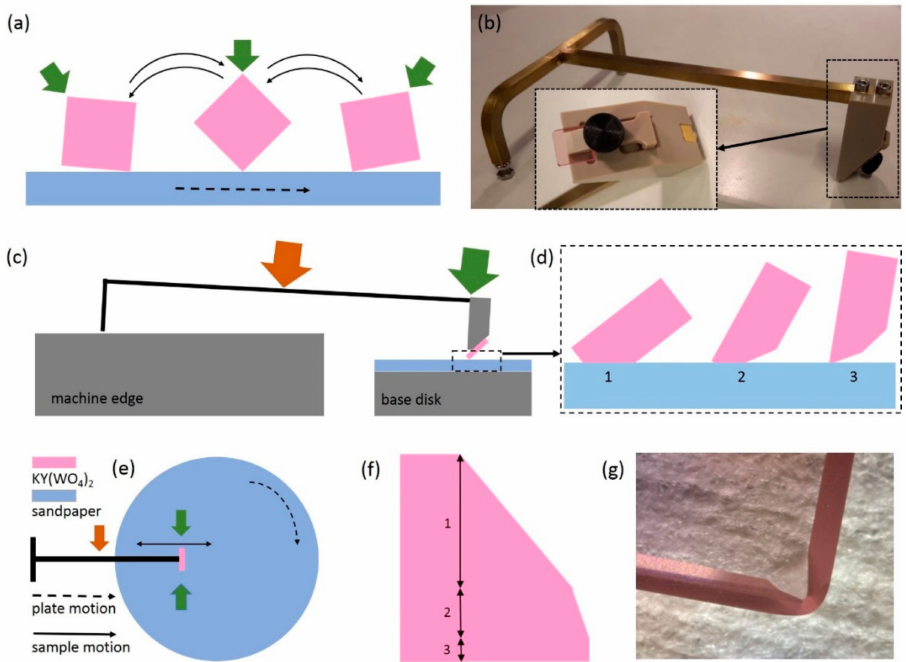
Figure 2. ( a ) Side view schematic representation of the motion during the process of rounding of the corners. The sample is held between the thumb and index finger at the corner pointed out by the green arrow. ( b ) Photograph of the beveling tool and a close-up (inset) view of the top of the tool with a sample (transparent pink) mounted for beveling. ( c ) Schematic representation of the relative position of the tool on the machine. The height of the base disk is increased to vary the contact angle. ( d ) Schematic representation of how to achieve di ff erent bevel angles using the setup shown in ( c ). ( e ) Top view schematic of the manual linear inward and outward motion of the sample on the rotating sandpaper. The head of the tool is held between the thumb and index finger to guide the sample. Pressure is exerted on the center of the bar of the tool with the index finger of the other hand (orange arrow). Note: During the process of rounding of the corners, the sample is held by hand instead of using the tool. ( f ) Schematic representation of the three areas of the beveled facets. The indicated areas, 1, 2, and 3, are consecutively made with 15 µ m SiC, 3 µ m Al 2 O 3 , and 0.3 µ m Al 2 O 3 sandpaper. ( g ) Close-up photograph of a beveled facets of a KY(WO 4 ) 2 sample with the mentioned grade of beveled facets, looking from the top of the